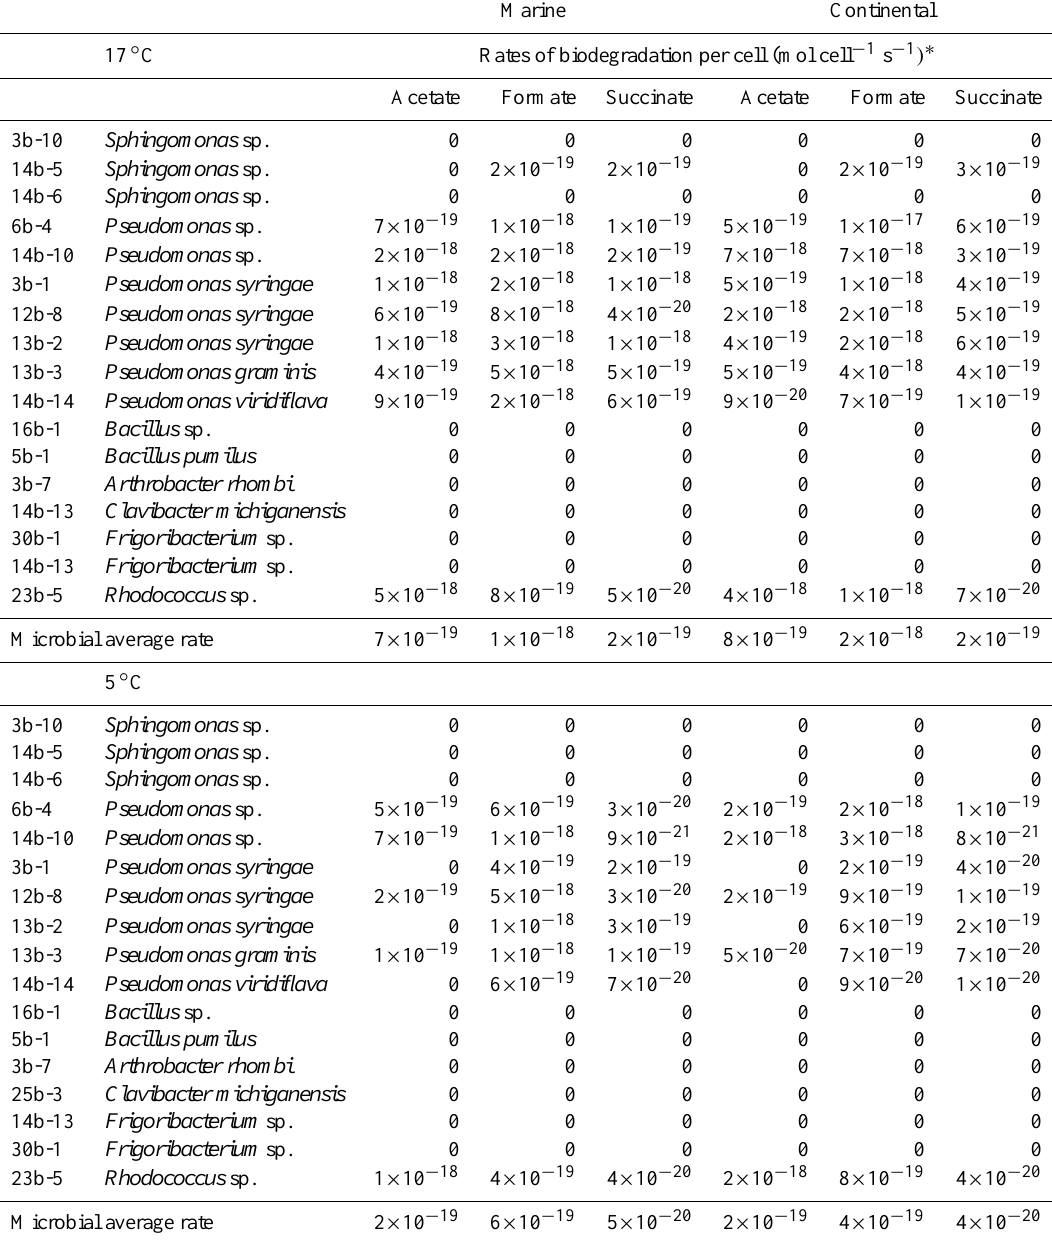
Table 2. Measured rates of biodegradation of carboxylic acids by pure strains at 5 and 17 ◦ C in the “marine” and “continental” artificial cloud water media.